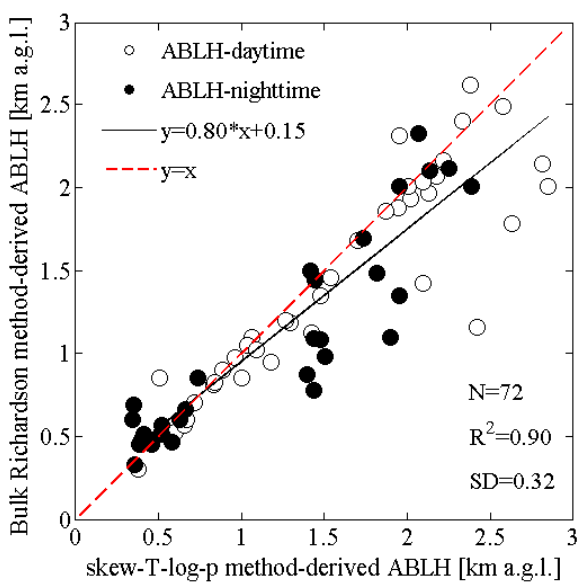
Figure 3. Correlation plots of ABLHs calculated using the skew-T-log-p method and the bulk Richardson method from rawinsonde at 00:00 and 12:00 UTC in Legionowo within the period of July to October 2013 for N = 72 data points coinciding with the data points depicted in Figure 2. The correlation coefficients were in the range 0.55–0.74 for the lidar rawinsonde and 0.59–0.90 for the ceilometer rawinsonde. As for comparisons of the skew-T-log-p with the lidar/ceilometer retrievals, they show consistent results with the bulk-Ri comparisons, with somewhat lower R 2 and SD. Based on the values given in Table 2, the WCT method performed the best, except for one case (the GDT for lidar in cloudy conditions). As for the analyses of the differences between the clear days